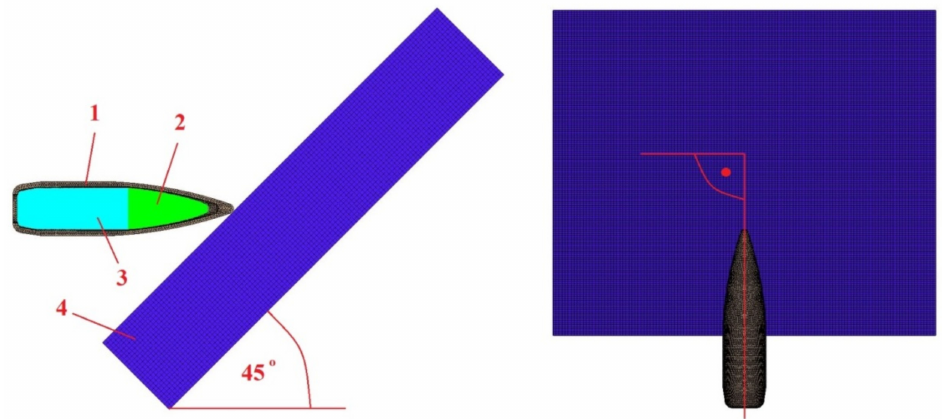
Figure 3. Numerical model of the 5.56 × 45 mm HC (SS109) projectile and Armox 600 plate: 1—tombac jacket, 2—steel core, 3—lead core, 4—Armox 600 armour